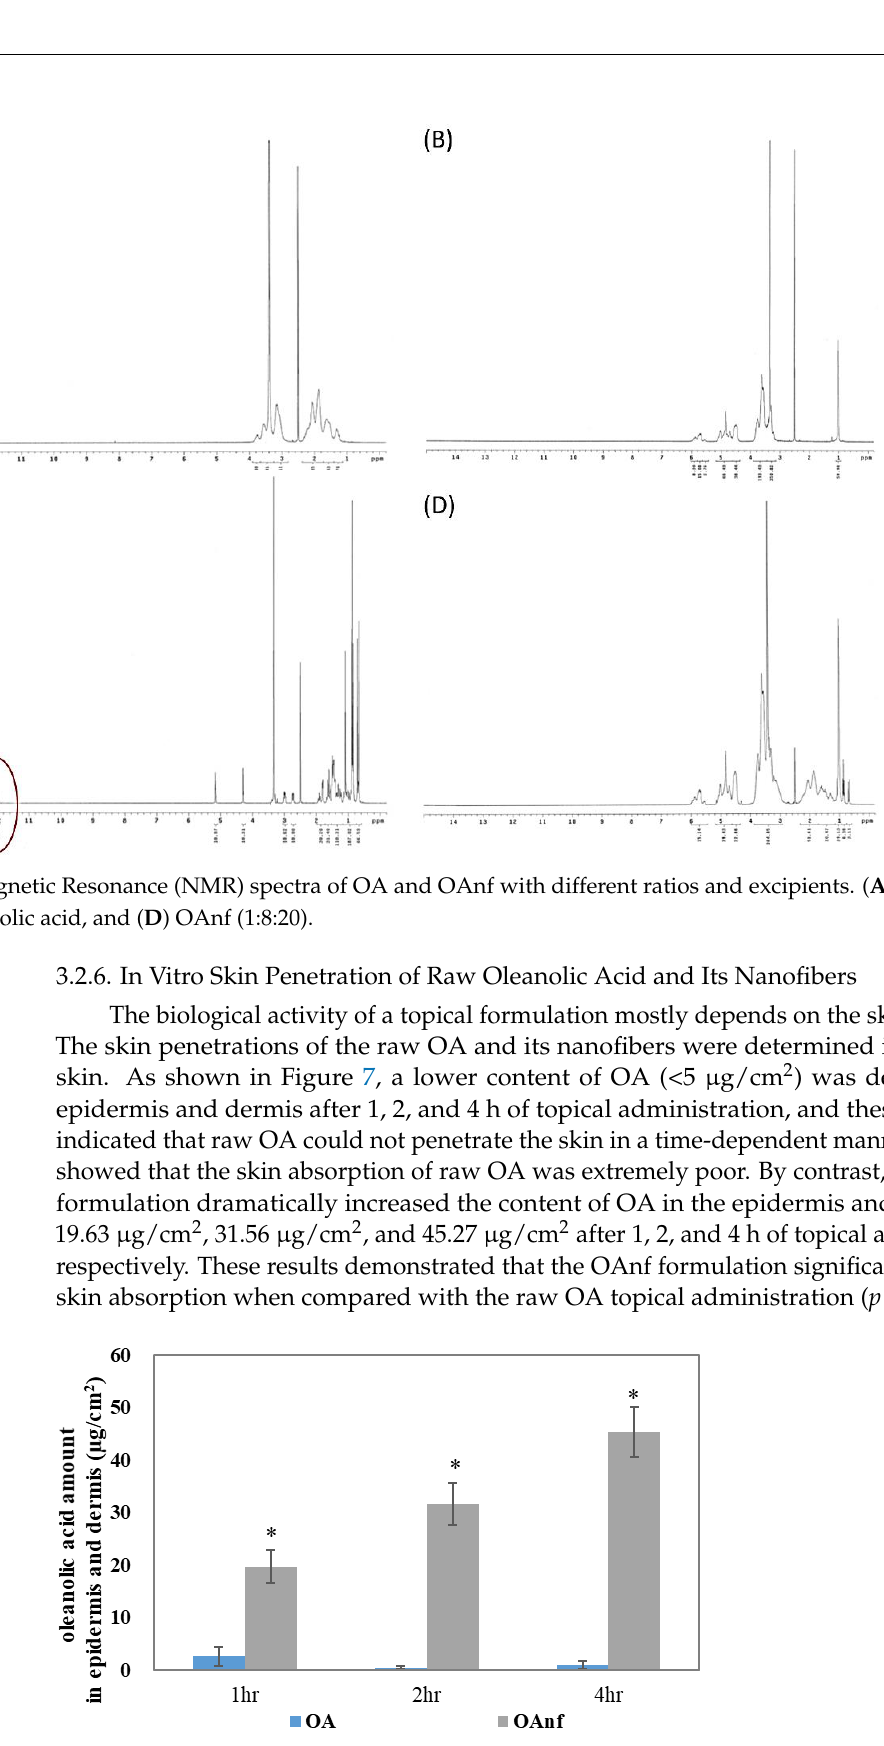
Figure 5. Fourier transform infrared (FTIR) spectra of OA and OAnf with different ratios and excip- ients. ( A ) PVPK90, ( B ) HPBCD, the different ratios of OAnf (OA: PVP: HPBCD, w / w / w ) ( C ) 1:8:5, ( D )